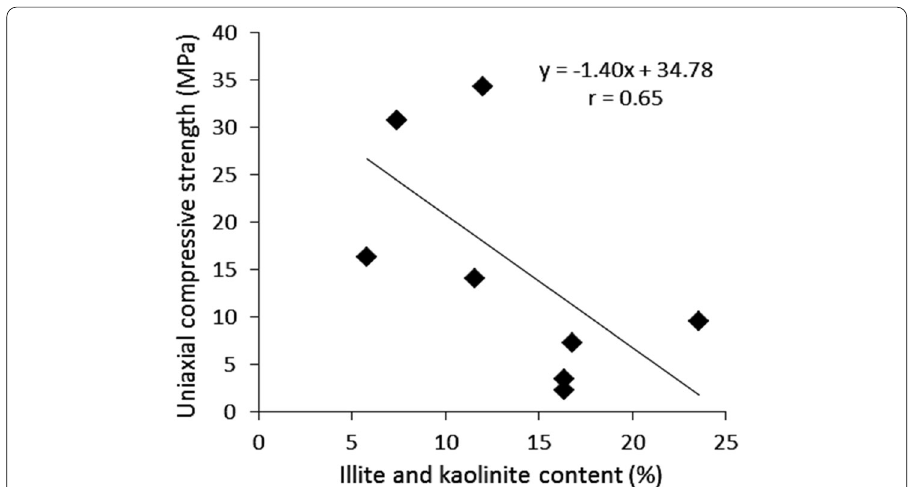
Fig. 14 Correlation between the UCS and the total illite and kaolinite